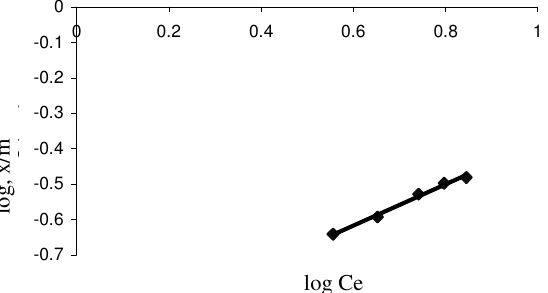
Figure 6. Freundlich plots for the adsorption of Grey BL.